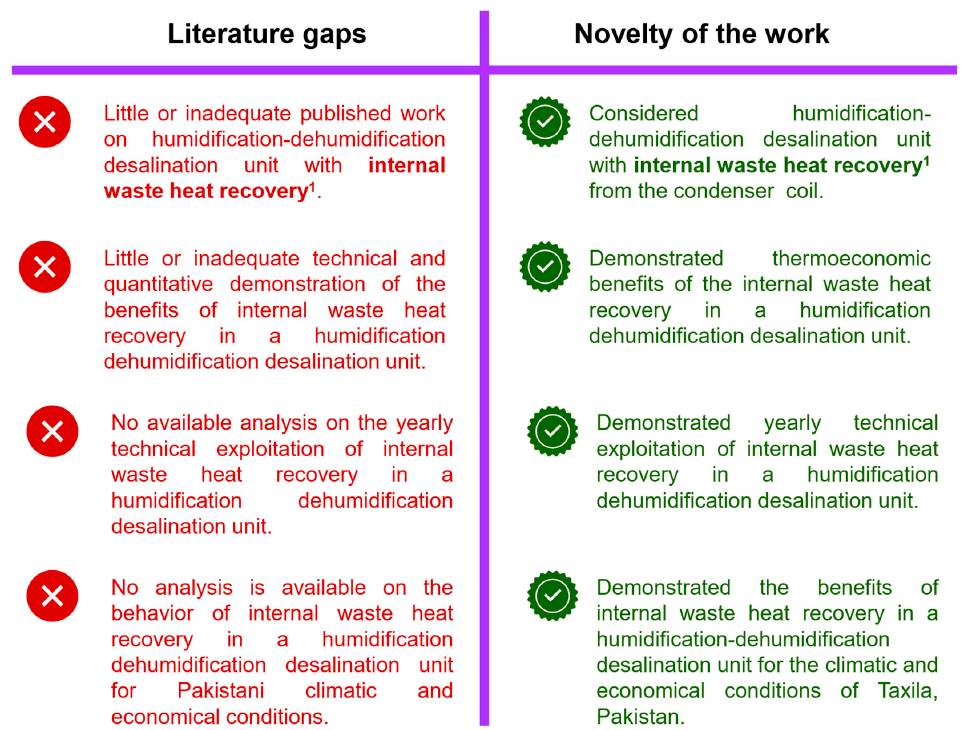
Figure 1. Checklist of various identified literature gaps which are addressed in this work contributing towards its novelty.